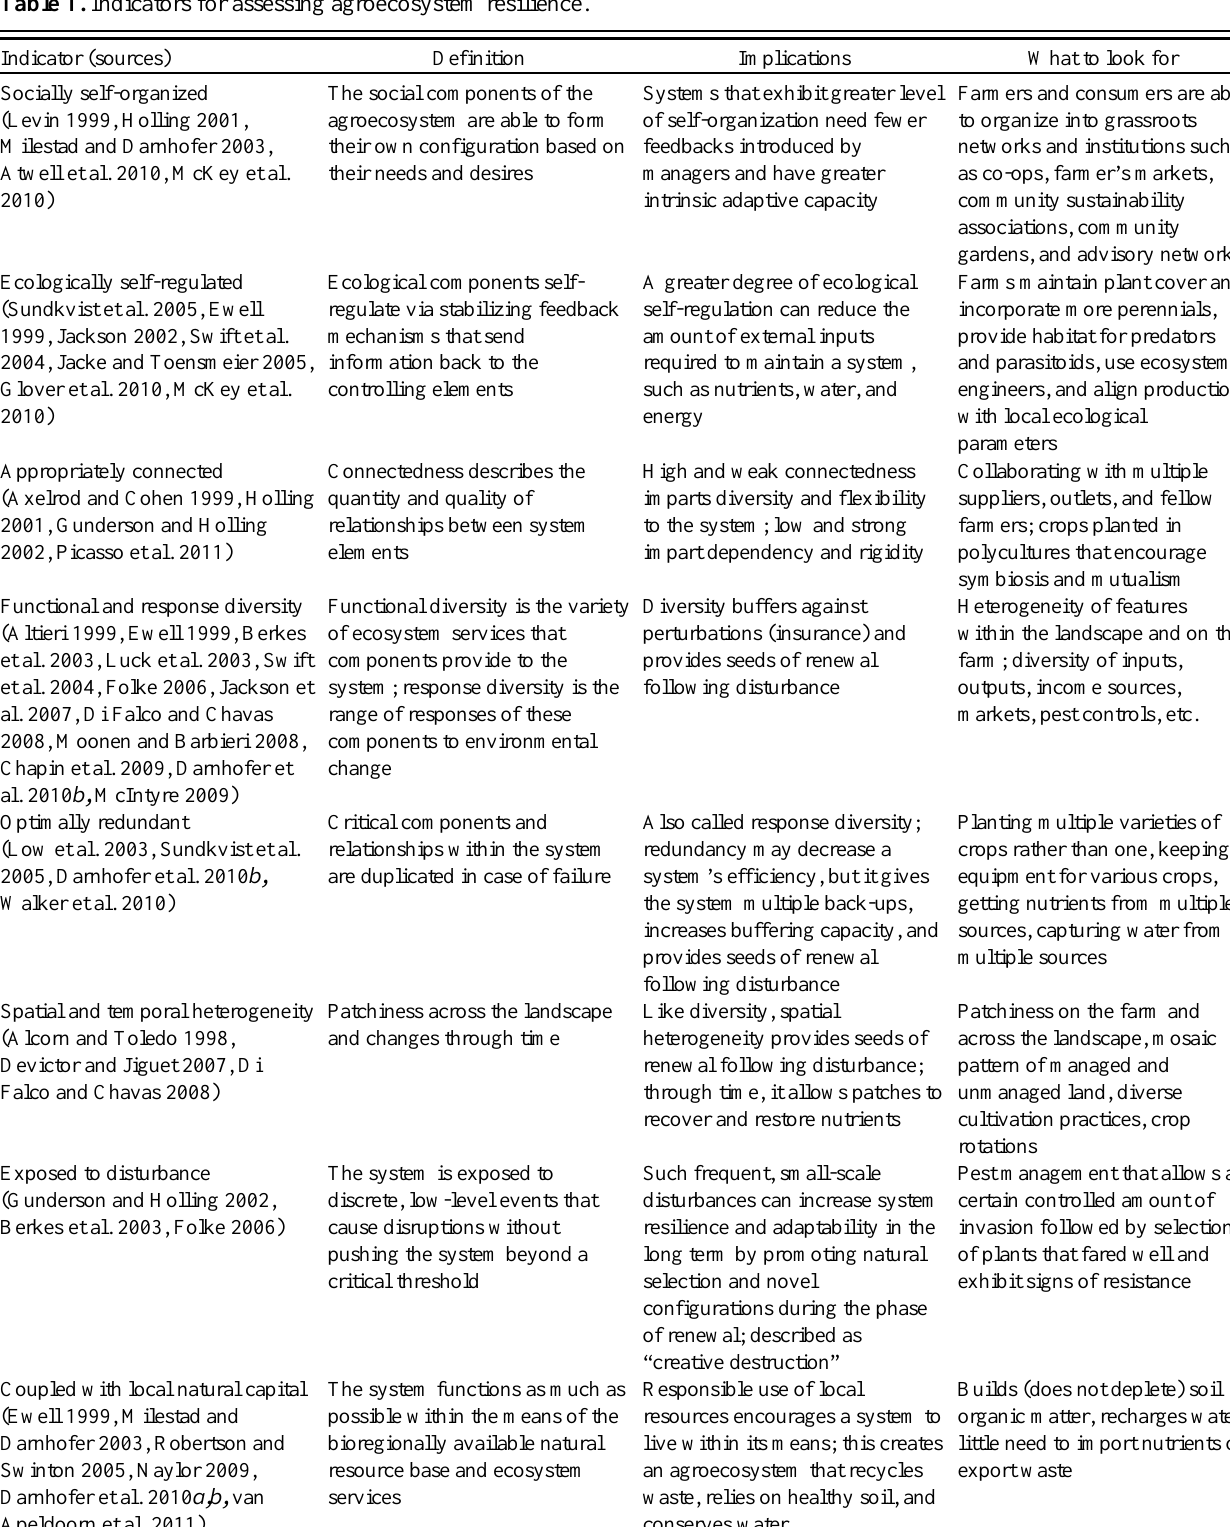
Table 1. Indicators for assessing agroecosystem